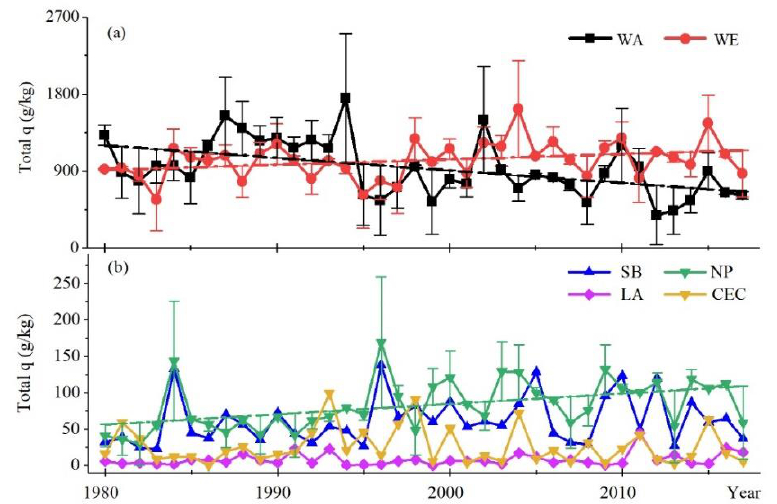
Figure 10. Scatter plot of precipitation in Northern Xinjiang at 28 sites versus total q (g/kg) in the WE ( a ), SB ( b ), and NP ( c ).